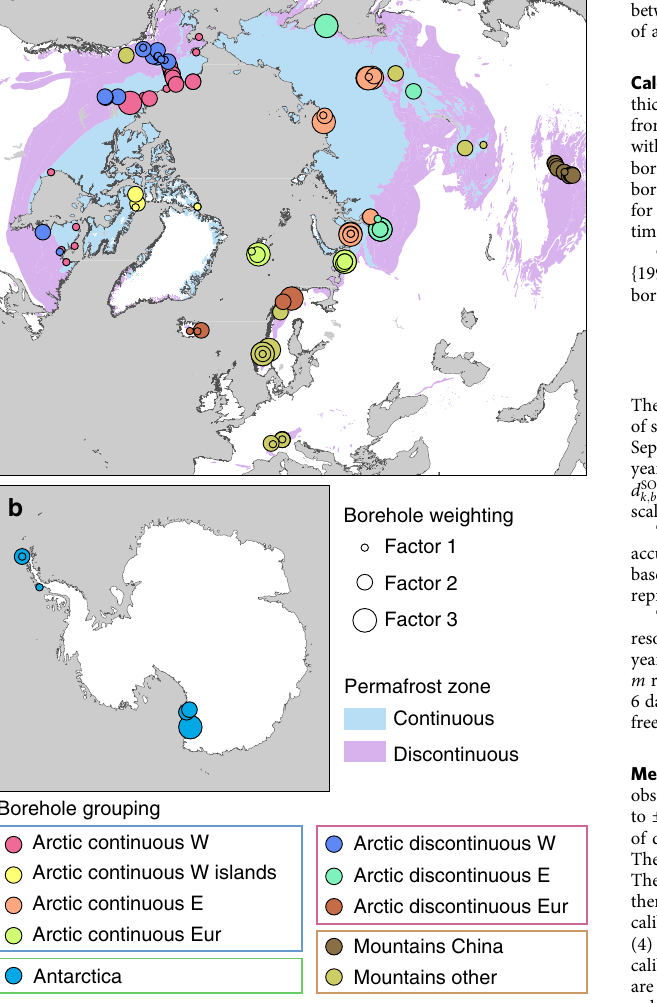
Fig. 8 Weighting and grouping of boreholes. Map showing the indices and zoning of boreholes prior to area-weighting and calculation of mean temperature changes. a Northern Hemisphere. b Antarctica. Permafrost zones are derived from the International Permafrost Association